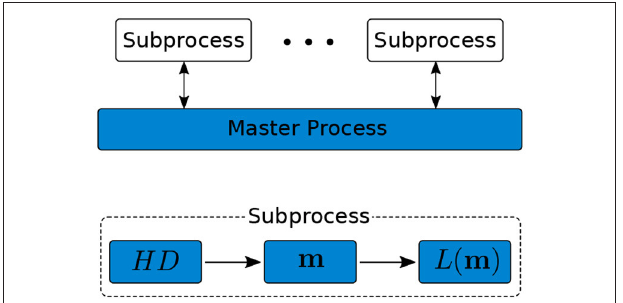
FIGURE 1 | Overview of the parallelized PoPEx